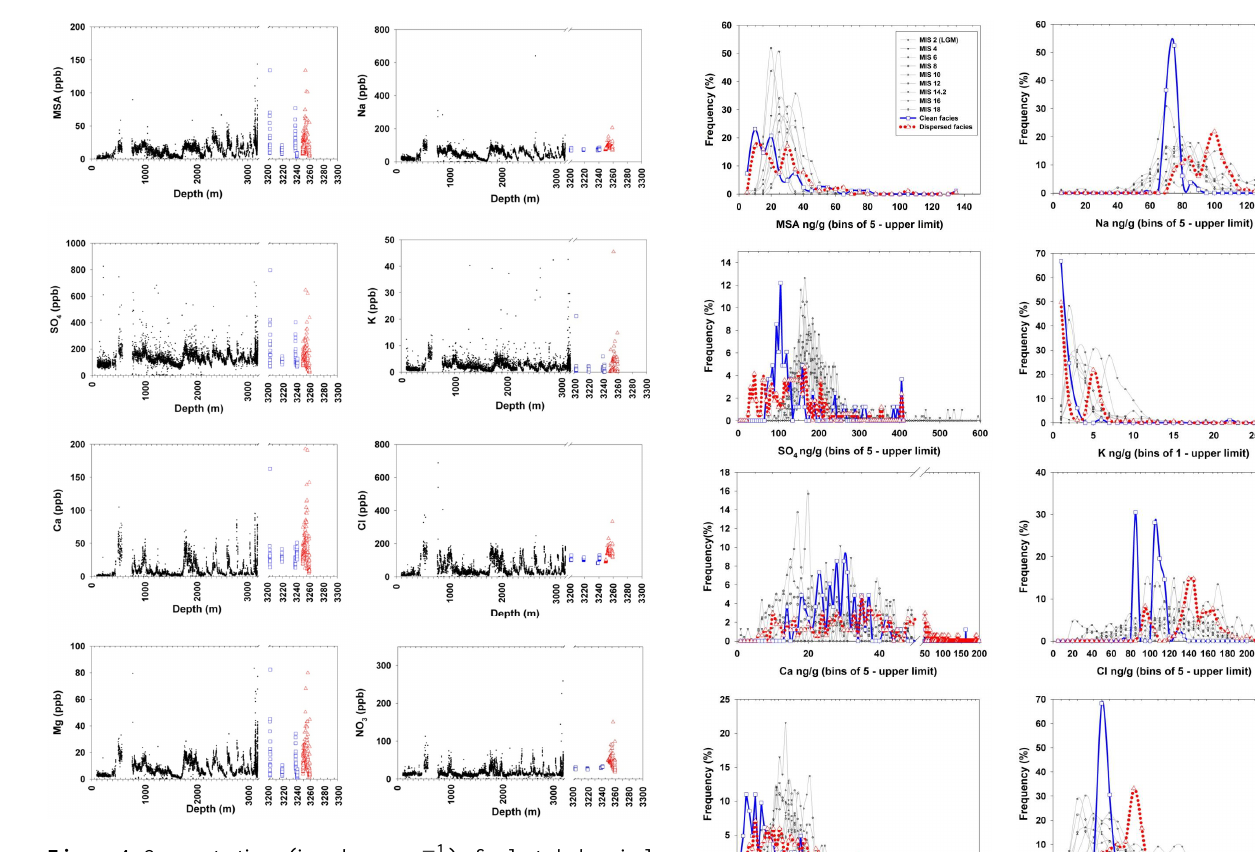
Figure 4. Concentrations (in ppb or ngg − 1 ) of selected chemical species in the clean (open blue squares) and dispersed (open red triangles) basal ice facies of the EPICA Dome C core, as compared to those of the preceding climatic cycles (black dots, courtesy of the EPICA chemical consortium). Resolution is between 5 and 8cm above 3200m depth and between 1.5 and 5cm in the basal ice below 3200m. Note the change of depth scale below 3200m.